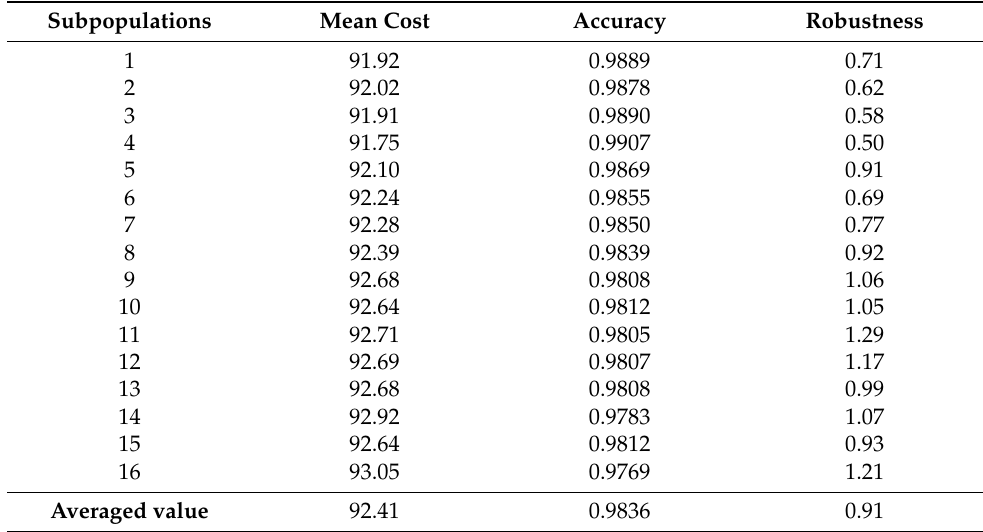
Table 9. Cross-section under biaxial bending. LSRD. Performance metrics.